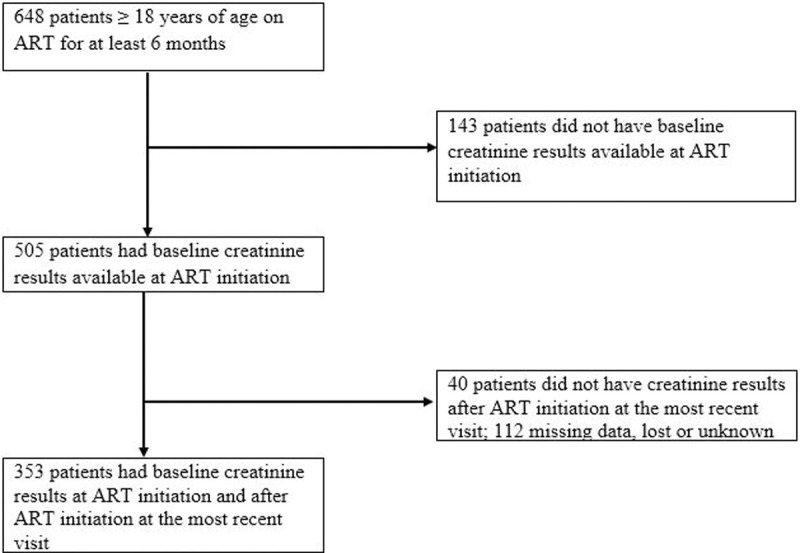
Flow diagram showing the number of patients included in the analysis.